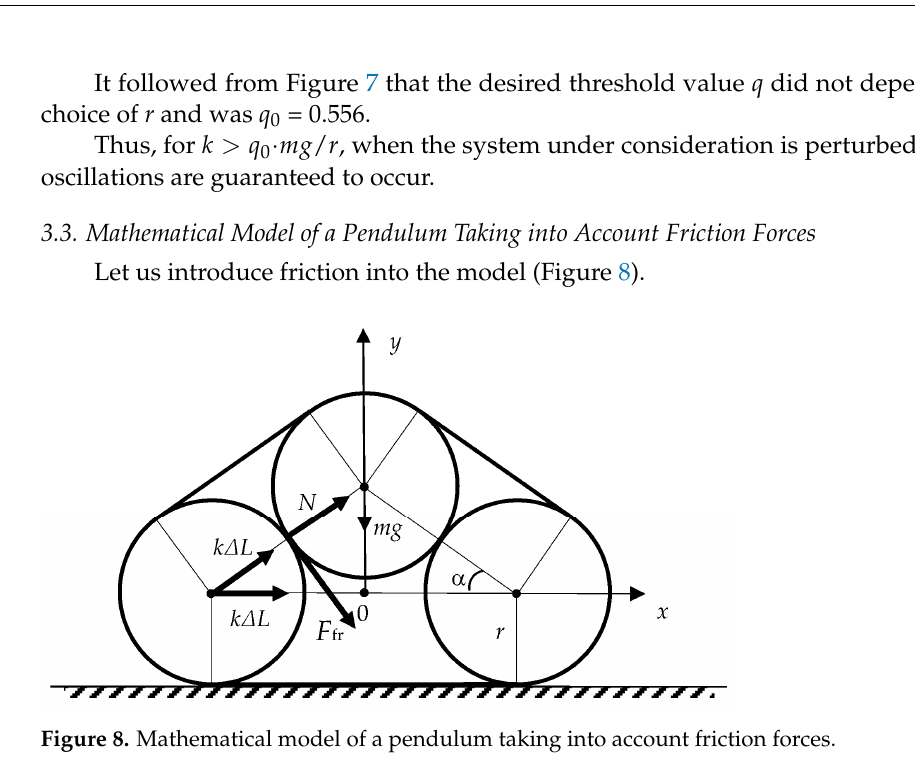
Figure 8. Mathematical model of a pendulum taking into account friction forces.